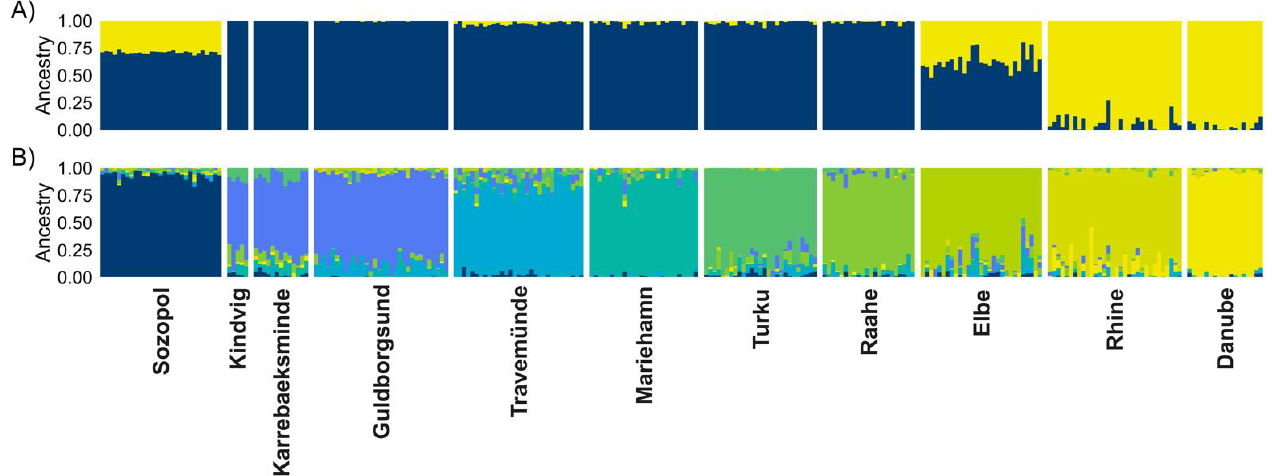
Figure 5. Individual ancestry estimates using sNMF of 264 round gobies ( Neogobius melanostomus ) based on 13,847 SNPs, for ( A ) K = 2 and ( B ) K = 9. Each vertical bar represents one individual; the colour represents the proportion of that individual assigned to the different K clusters. Clusters 3–8 can be found in the Supplementary Figure